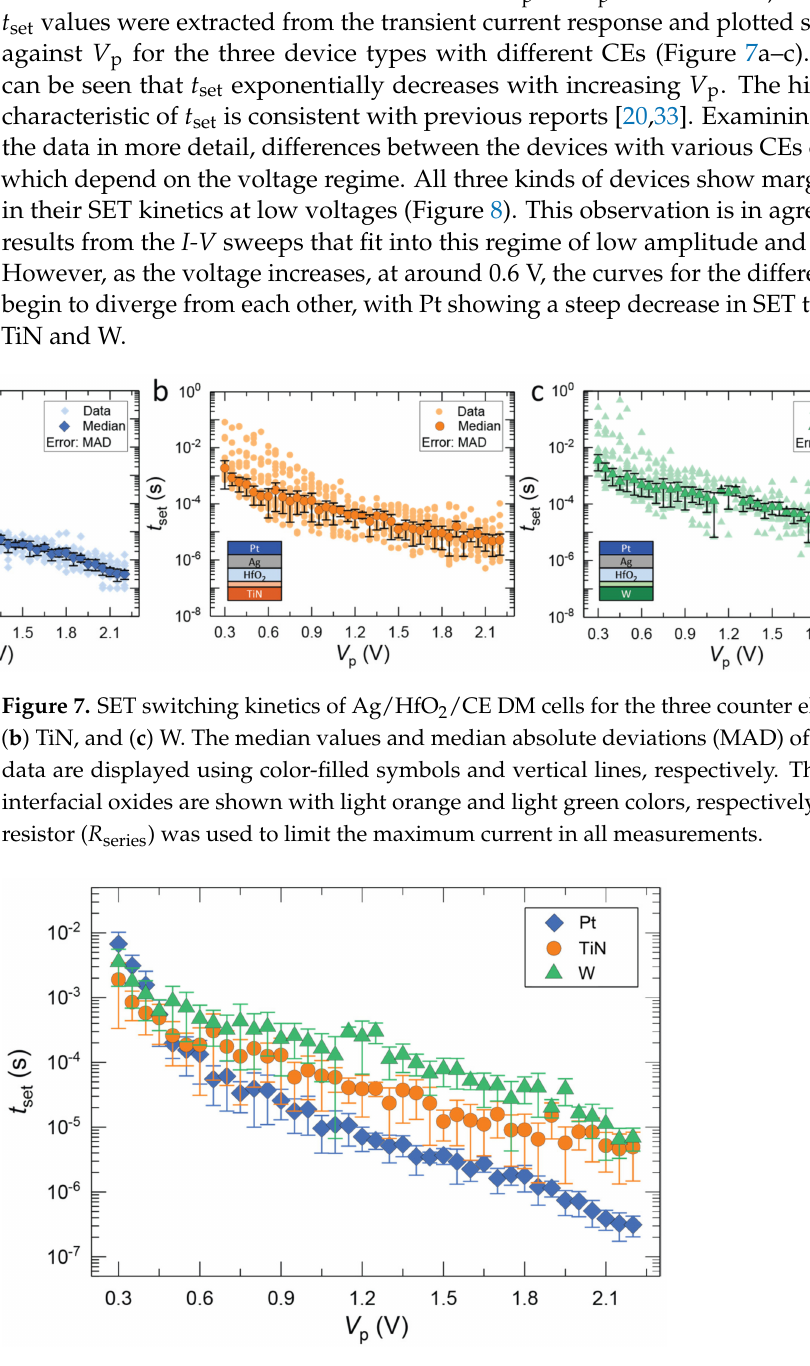
Figure 8. A SET kinetics plot of the median values of SET time ( t set ) as a function of programming voltage ( V p ) for the Ag/ 3 nm HfO 2 /CE devices with the three different CEs of Pt, TiN, and W. The error bar is the median absolute deviation (MAD) of the experimental